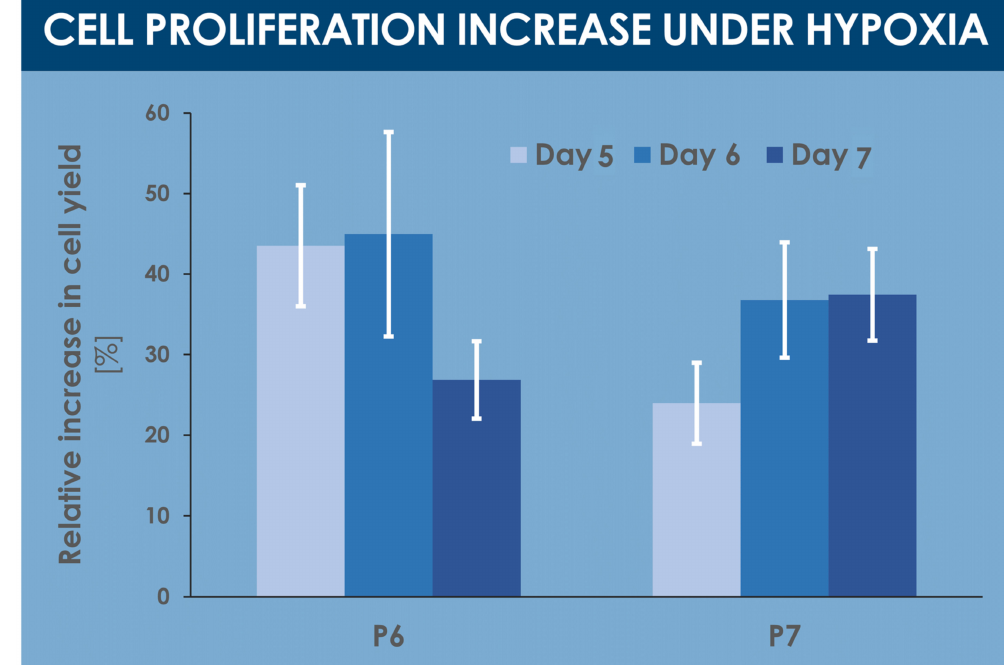
Figure 3. Comparative results of proliferative and endpoint cell yields, presented as the mean relative cell yield increases observed in hypoxia conditions vs. normoxia conditions. Various harvest endpoints were investigated for hFPTs at passage levels of 6 and 7, respectively. Results are presented as mean values, with corresponding standard deviations as error bars. hFPT, human fetal progenitor tenocytes; P, passage level. Table 1. Population doubling values for hFPTs harvested between days 5 and 7 of incubation in normoxic or hypoxic conditions at passage levels of 6 and 7, respectively. Statistically significant differences between mean values, determined using a unilateral paired t -test, are evidenced with an asterisk “*”. hFPT, human fetal progenitor tenocytes; SD, standard deviation. Population Doubling Values (Mean ± SD) Passage 6 Cells p -Values Passage 7 Cells p